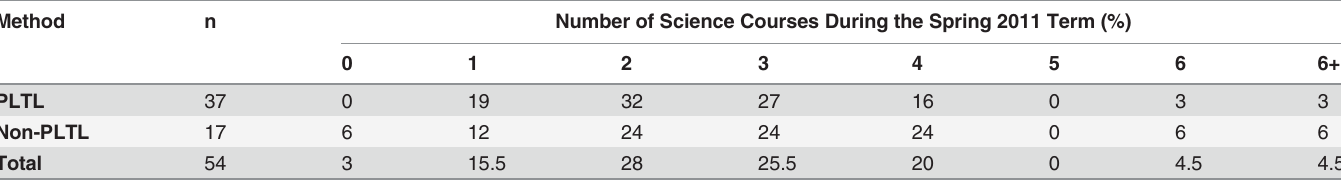
Table 4. Number of Science Courses taken During Spring 2011 for PLTL and Non-PLTL Groups.